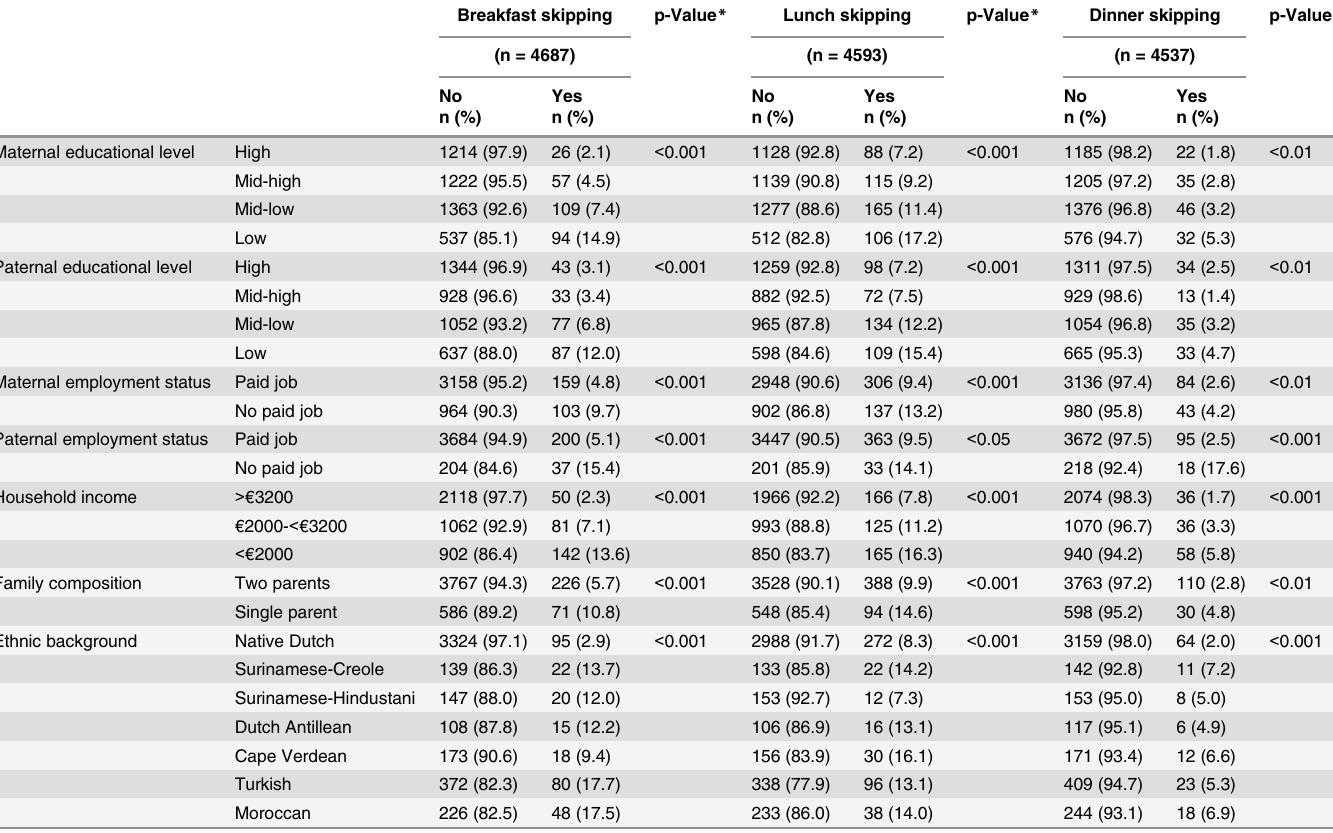
Table is based on non-imputed